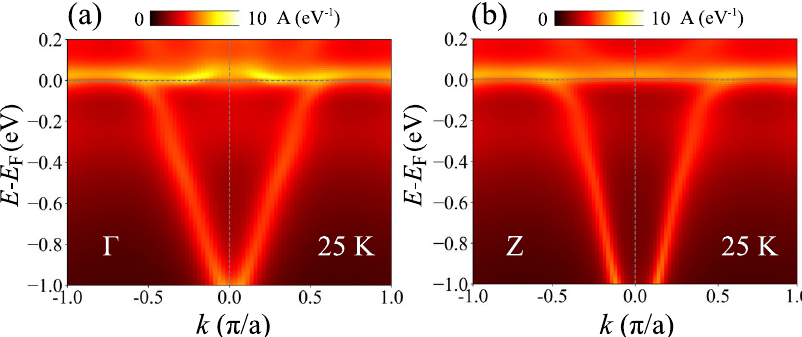
Fig. 4 Momentum-resolved spectral function. Momentum-resolved spectral function along the ( a ) X- Γ -X and ( b ) X 1 -Z-X 1 . The simulation temperature is 25 K for